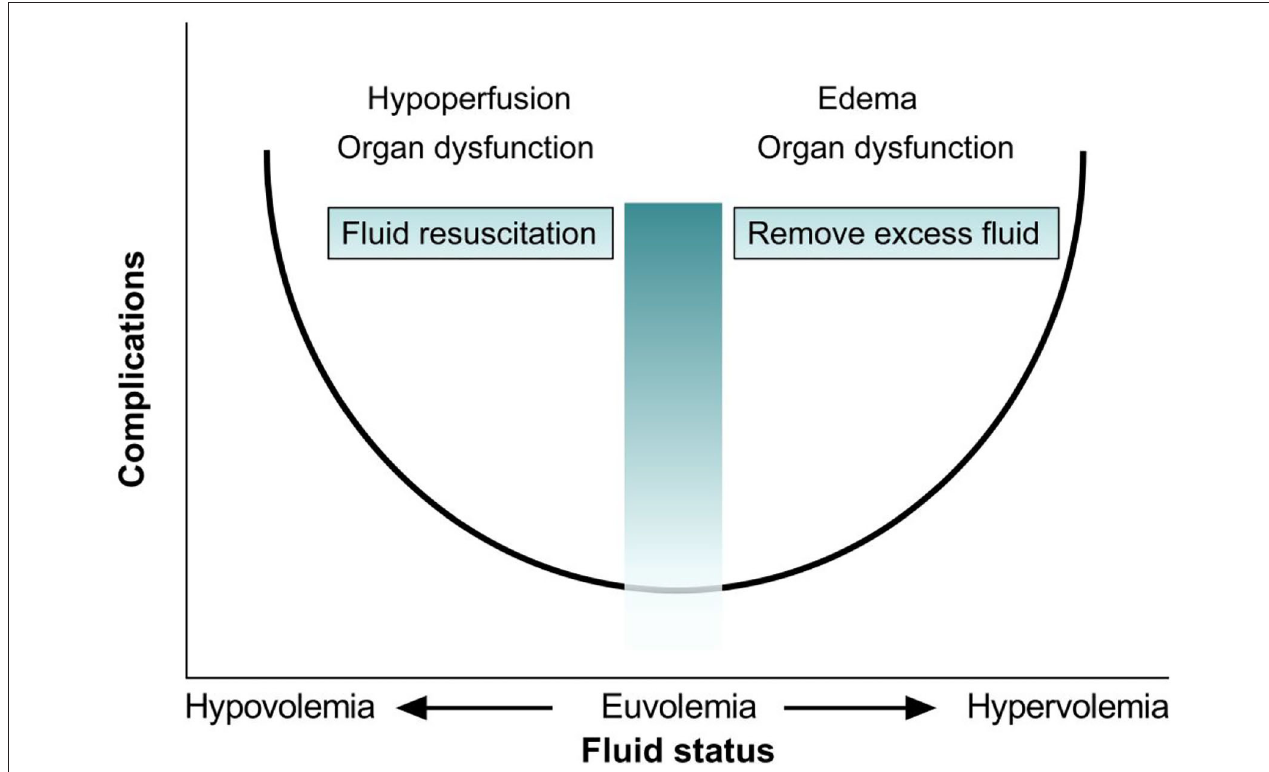
FIGURE 4 | Relation between fluid volume status and